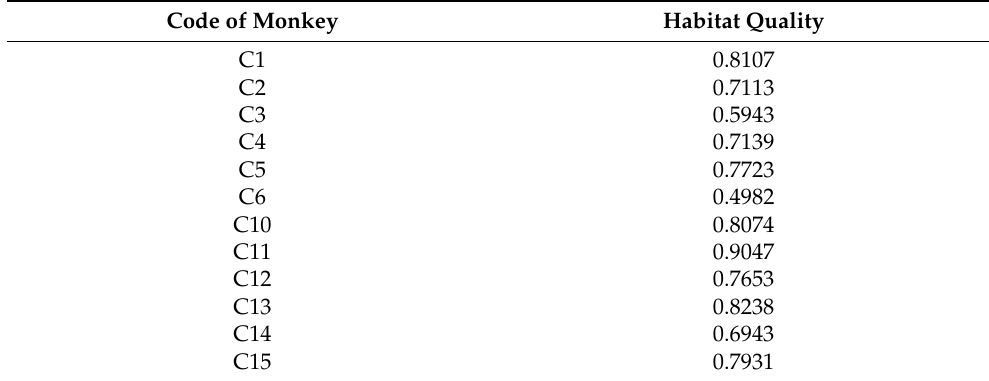
Table 9. The value of habitat quality in each monkey